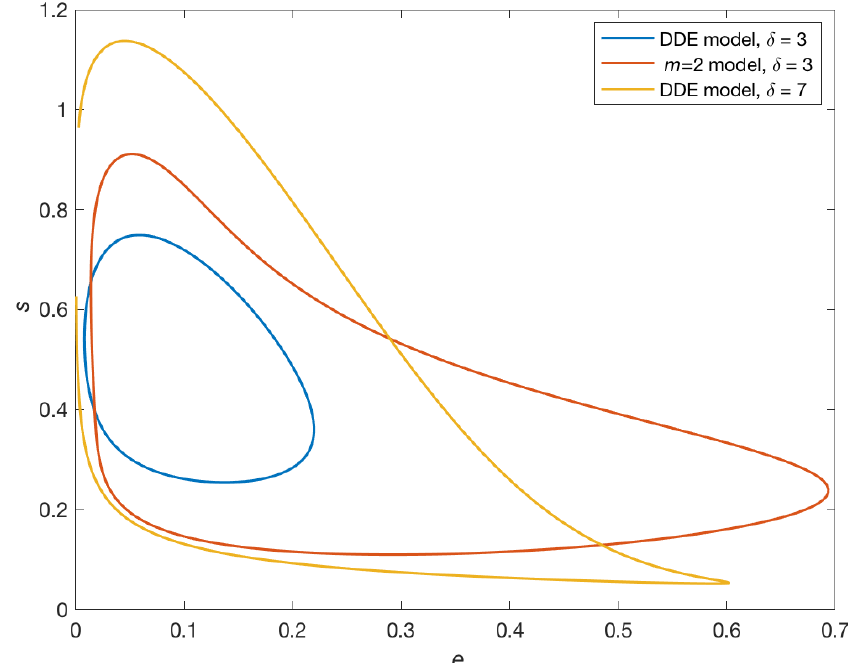
Figure 10. Trajectories of the DDE model (21) and of the system reduced to the inertial manifold for m = 2. The parameters for the first two curves are those of Figure 9. In particular, δ = 3. For the third curve, the DDE model was integrated with δ increased to